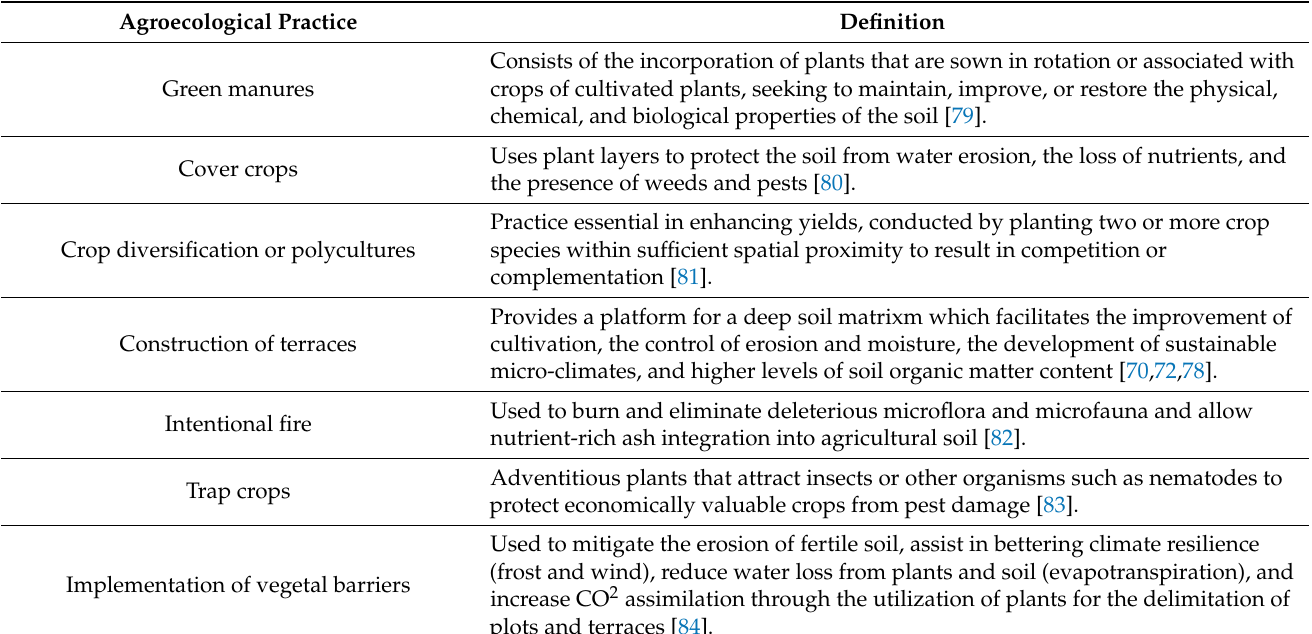
Table 1. Pre-Hispanic agroecological practices registered in the Andean